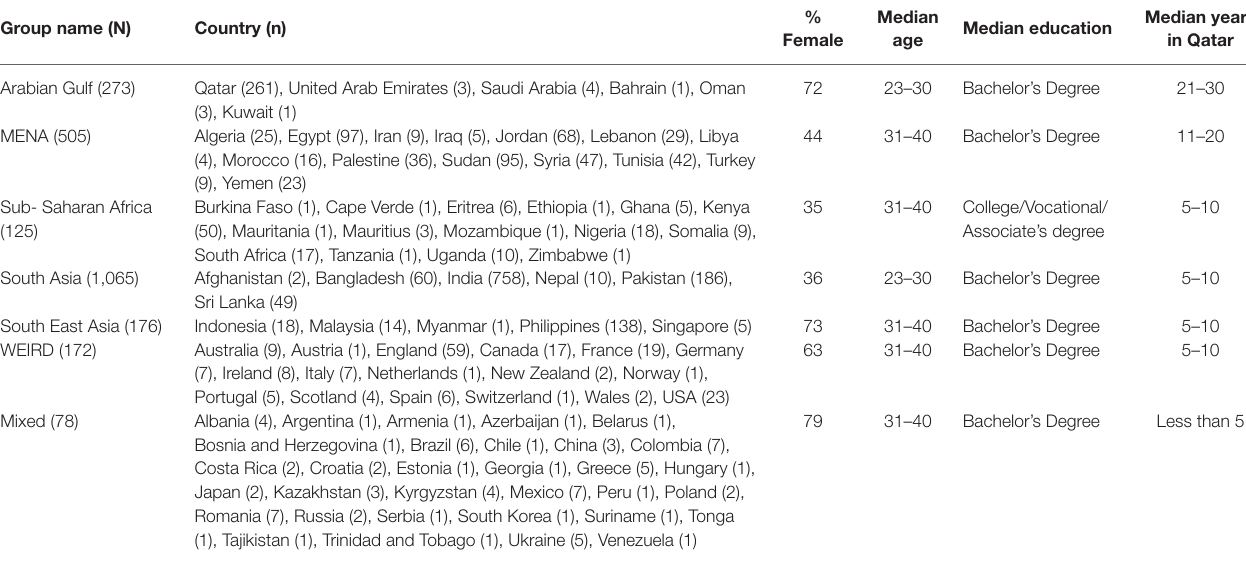
TABLE 2 | Country names (respondent number) by regional group and associated group percentage of female respondents, median age, median education and median years in